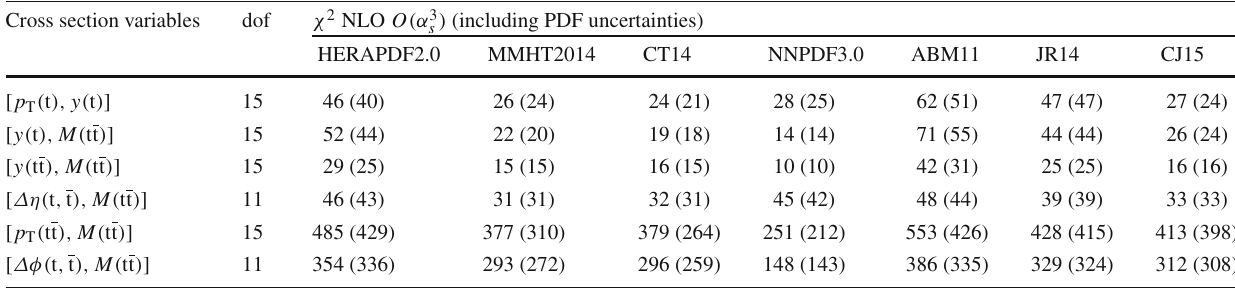
Table 2 The χ 2 values and dof of the double-differential normalized tt cross sections with respect to NLO O (α 3 s ) theoretical calculations [18] using different PDF sets. The χ 2 values that include PDF uncertainties are shown in parentheses Cross section variables dof χ 2 NLO O (α 3 s ) (including PDF uncertainties) HERAPDF2.0